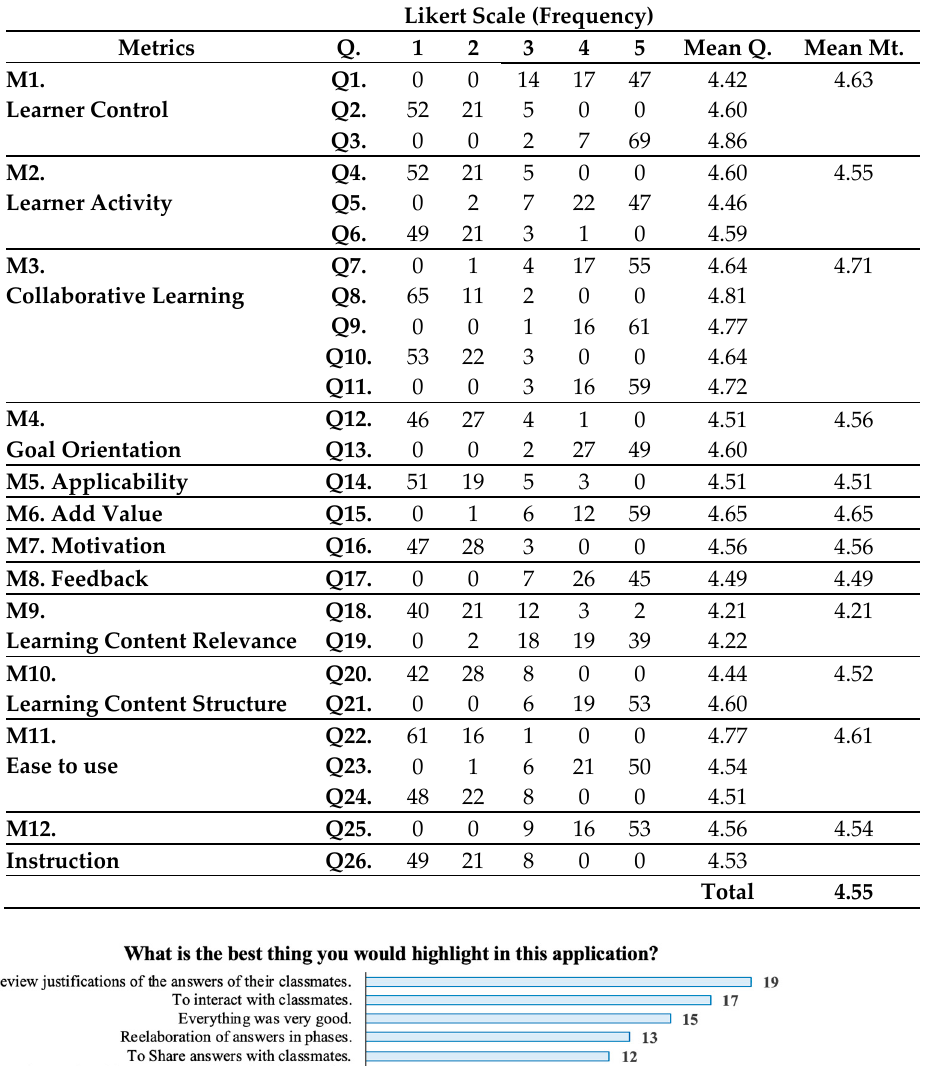
Table 2. Results of the pedagogical usability. Frequencies of responses to the 5-point Likert-scale. Mt. = Metrics, Q. = Questions. 1 = “strongly disagree”. 5 = “strongly agree”.